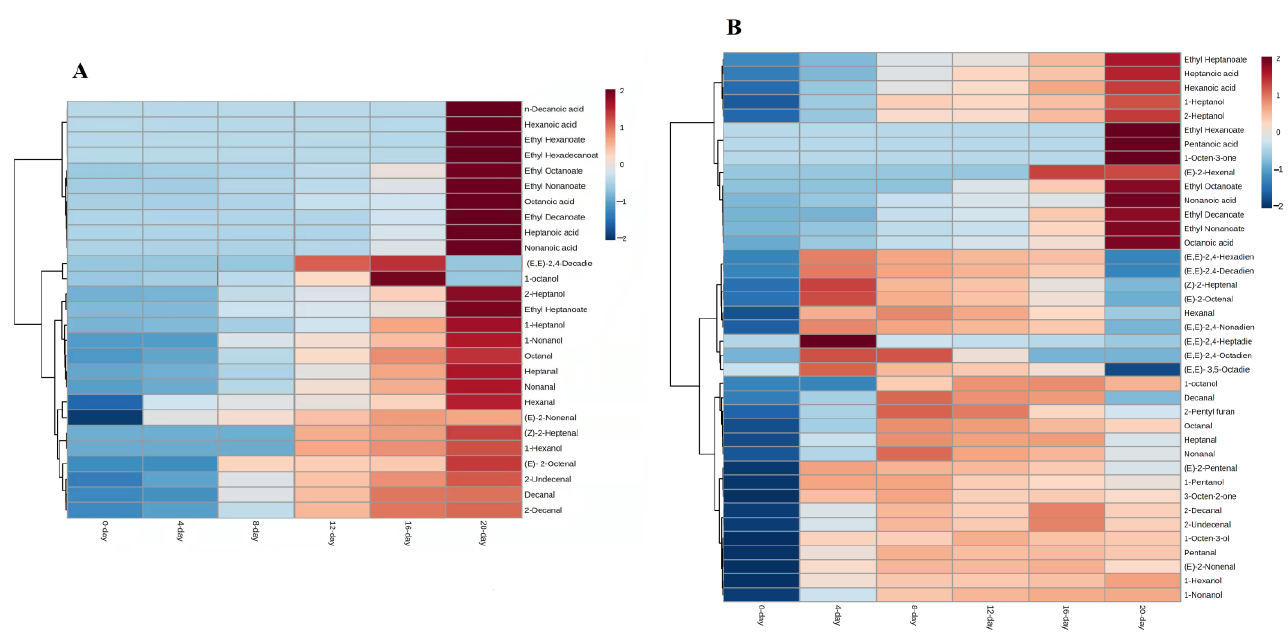
Figure 4. Heatmap visualization of UFAO-derived compounds in model reaction by erucic acid ( A ) and all fatty acid ( B ).